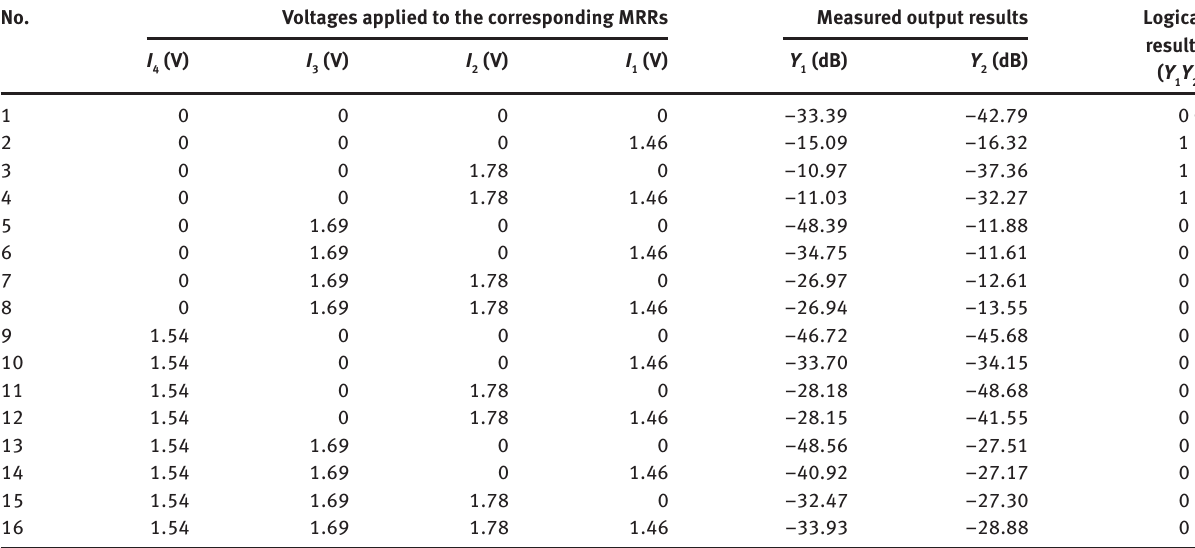
Table 2: Priority encoding results of the proposed